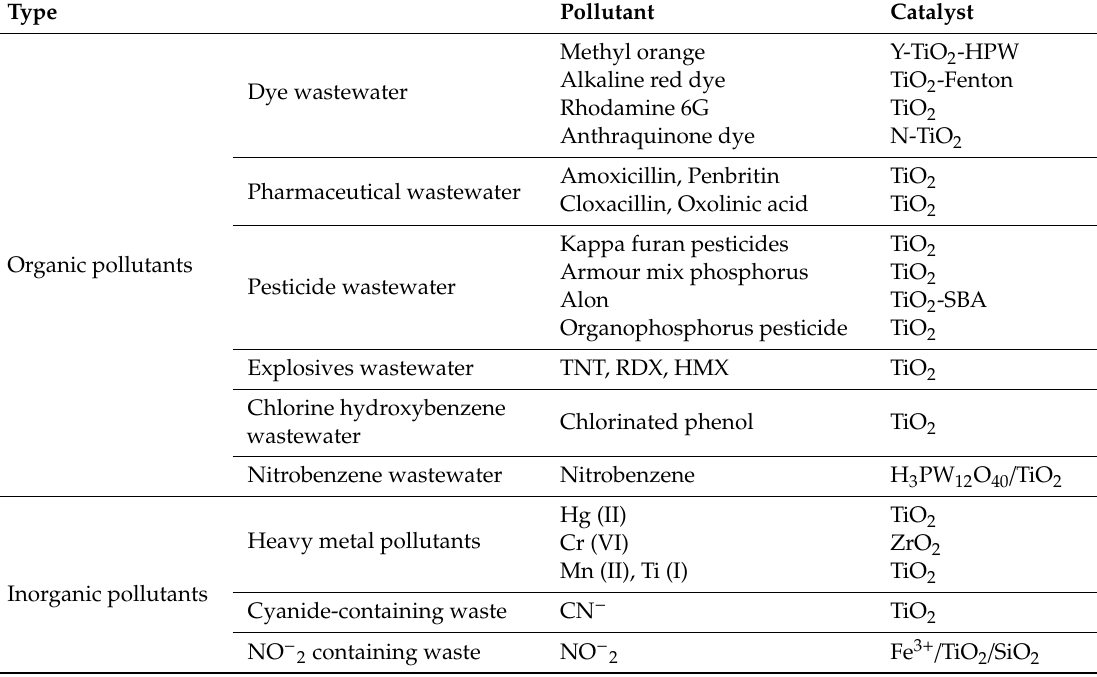
Table 2. TiO 2 photocatalytic degradation of organic and inorganic pollutants. With some modifications from